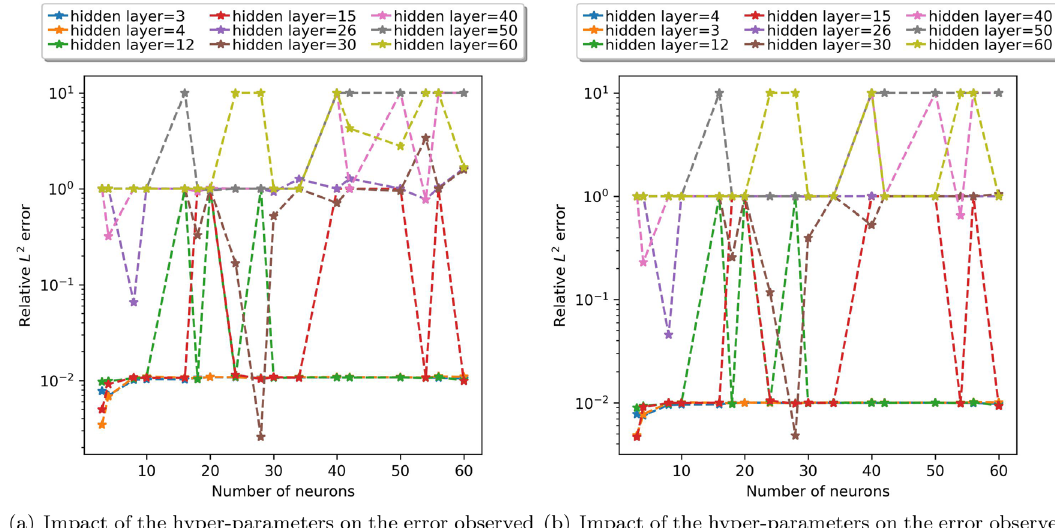
Figure 6. Number of neurons versus